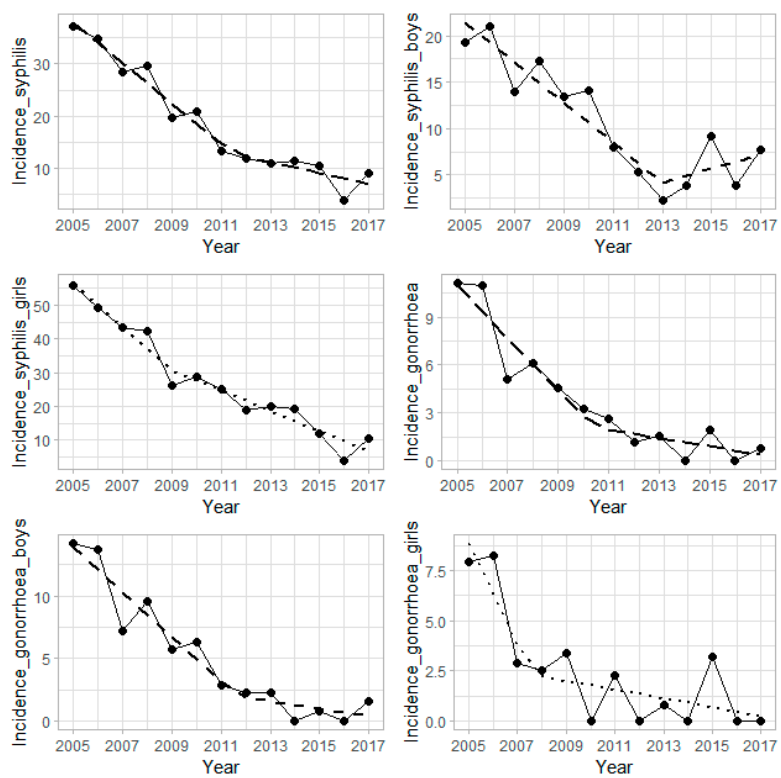
Figure 1. Trends in crude incidence rates of syphilis and gonorrhea in age groups of 15–19 years in the central and northwestern Romania, from 2005 to 2017. The analyzed temporal distribution was represented by continuous line graph, while estimated trends were marked by dotted lines.